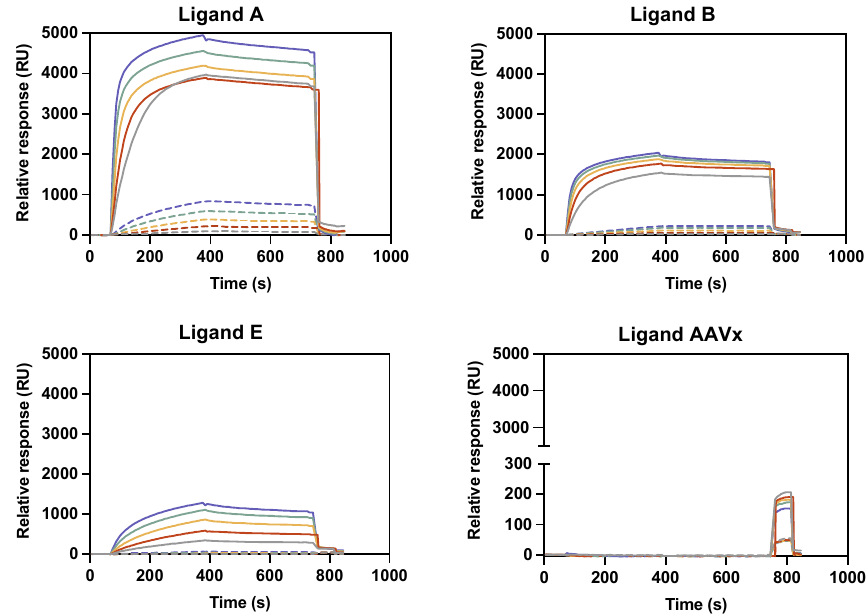
Figure 1. LVs binding reactivity using biotin–ligand conjugates. Representation of the SPR sensor- grams containing the relative response (RU) versus time (s). The three different interaction profiles observed between the VSVG-LVs and the novel ligands are illustrated by the ligand A, B, E and by the negative control with the AAVX ligand. For each ligand, different binding responses were obtained by varying the dilution of a VSVG-LVs feedstock injected (2-fold dilutions from 10 to 160 times). Color code: blue represents 10 times dilution, green represents 20 times dilution, yellow represents 40 times dilution, red represents 80 times dilution, and gray represents 160 times dilution. Solid lines represent the experiments performed using the maximum biotinylated V H H fragments concentration (20 µ g/mL) spotted onto a Strep G Senseye biosensor chip, whereas dashed lines represent the minimum concentration used (0.02 µ